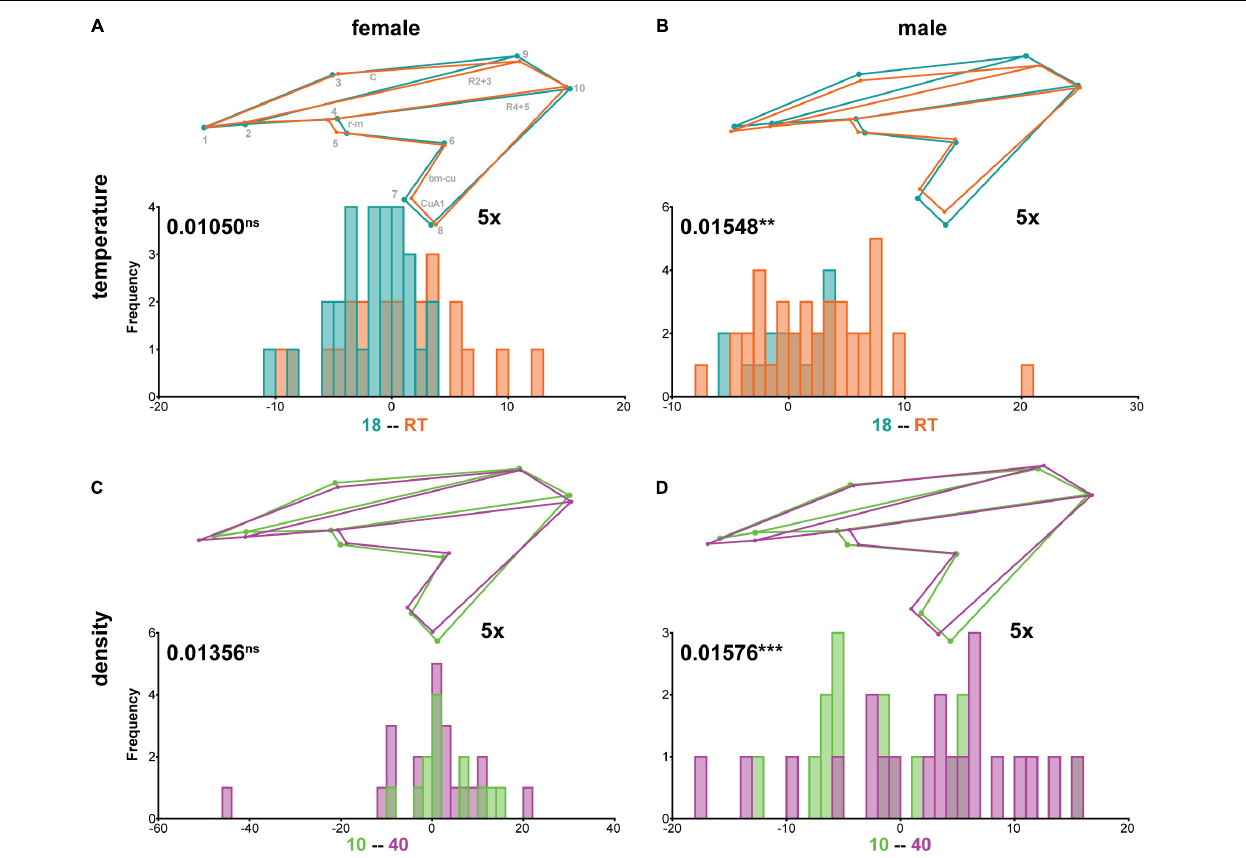
FIGURE 6 | Sex-specific non-allometric shape differences due to different rearing temperatures and densities in M. domestica. Summary of discriminant function analyses for non-allometric shape differences for flies raised at different temperatures (A,B) or densities (C,D) . The wireframes represent differences between the low temperature (turquoise) and high temperature (orange) (A,B) and the low density (green) and high density (purple) (C,D) average wing shapes, respectively. The scale factor is provided next to the wireframes. The magnitude of shape variation is indicated in units of Procrustes distance with the corresponding p -values based on 1,000 random permutations ( ns P > 0.05; ** P ≤ 0.01; and *** P ≤ 0.001). Histograms with the distributions of the discriminant scores show shape separation into two distinct groups for each species. See also Supplementary Table 5 for